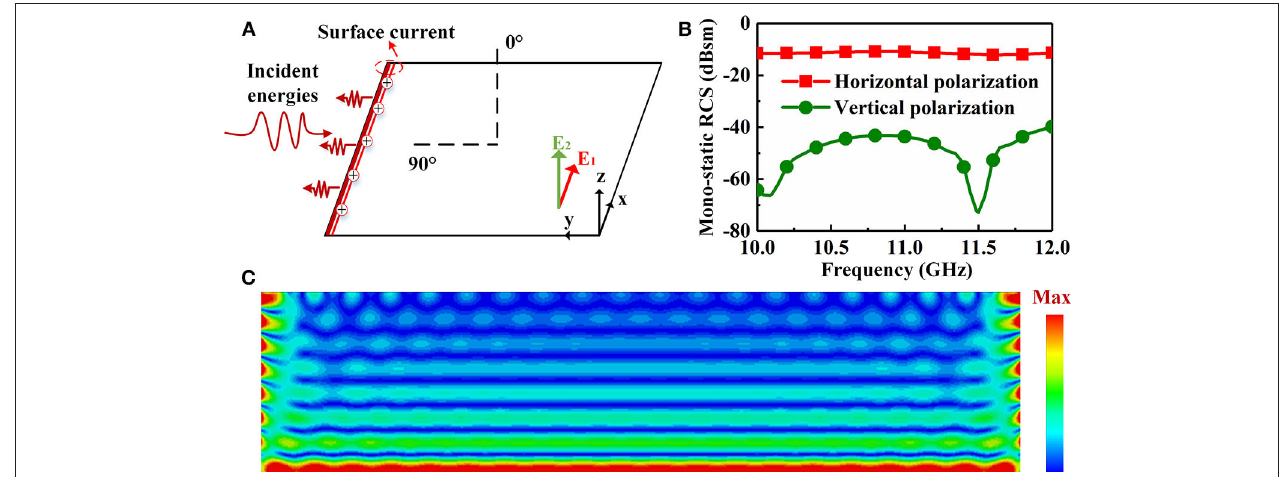
FIGURE 2 | Illustrations of edge scattering of a thin rectangular metal plate. (A) Edge scattering at an incident angle of 90 ◦ . (B) The mono-static RCS of edge scattering under horizontal and vertical polarization. (C) Surface current on metal plate under a horizontal polarized